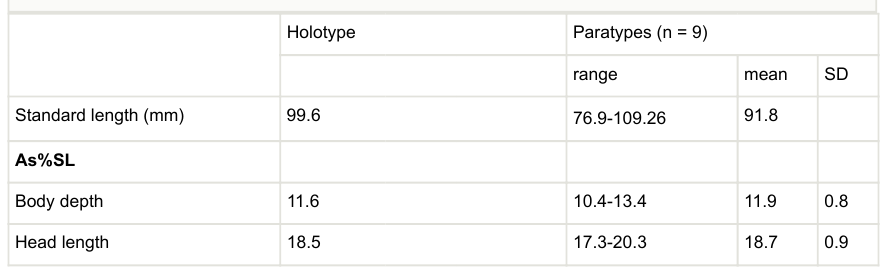
Trials and morphometric characters of Homatula guanheensis sp.